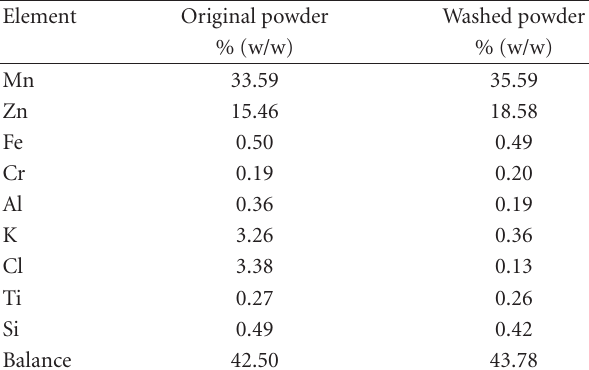
Table 6: Semiquantitative analysis of the original and washed